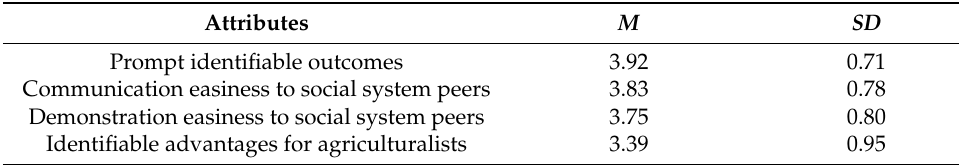
Table 6. Demonstrability’s Innovation Metrics ( n = 334).